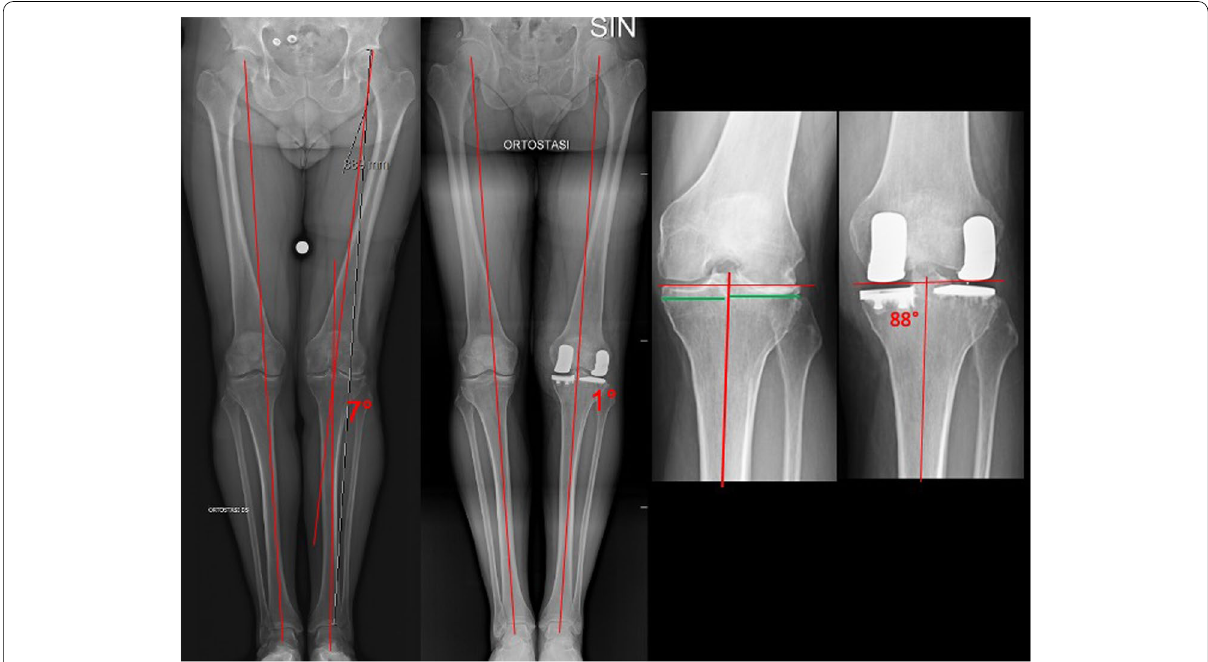
Fig. 3 Respect of the morphotype. Same case of Fig. 1. The native coronal alignment of the patient was in varus, so the preoperative planning was performed with the aim to restore the native